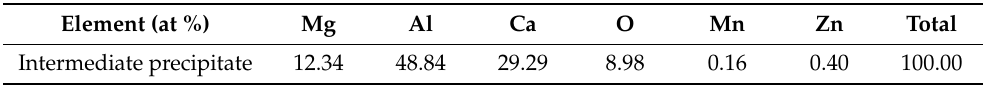
Figure 10. TEM observation on intermediate precipitate in the Mg – Al – CaO precursor with 10-vol % CaO particles after the heat treatment at 500 °C for 300 s. Table 2. Chemical compositions of intermediate precipitates in the Mg – Al – CaO precursor with 10-vol % CaO particles after the heat treatment at 500 °C for 300 s. Element (at %) Mg